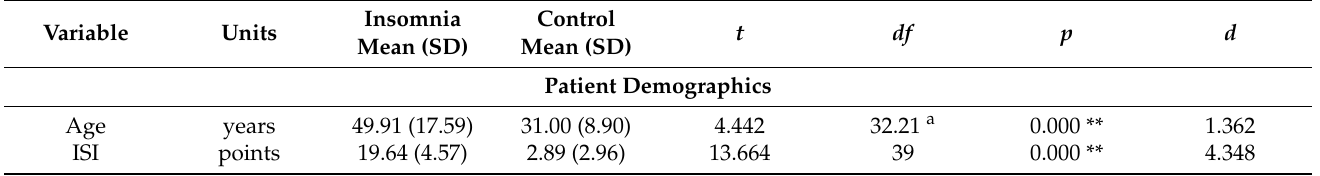
Table 1. Participant demographics and sleep characteristics between the insomnia ( n = 22) and control ( n = 19) groups. Variable